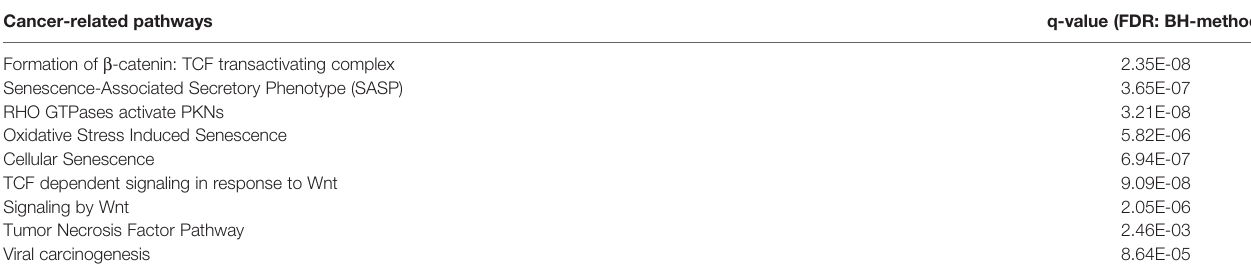
TABLE 1 | ESR1 overexpression modulated genes associated with cancer pathways.